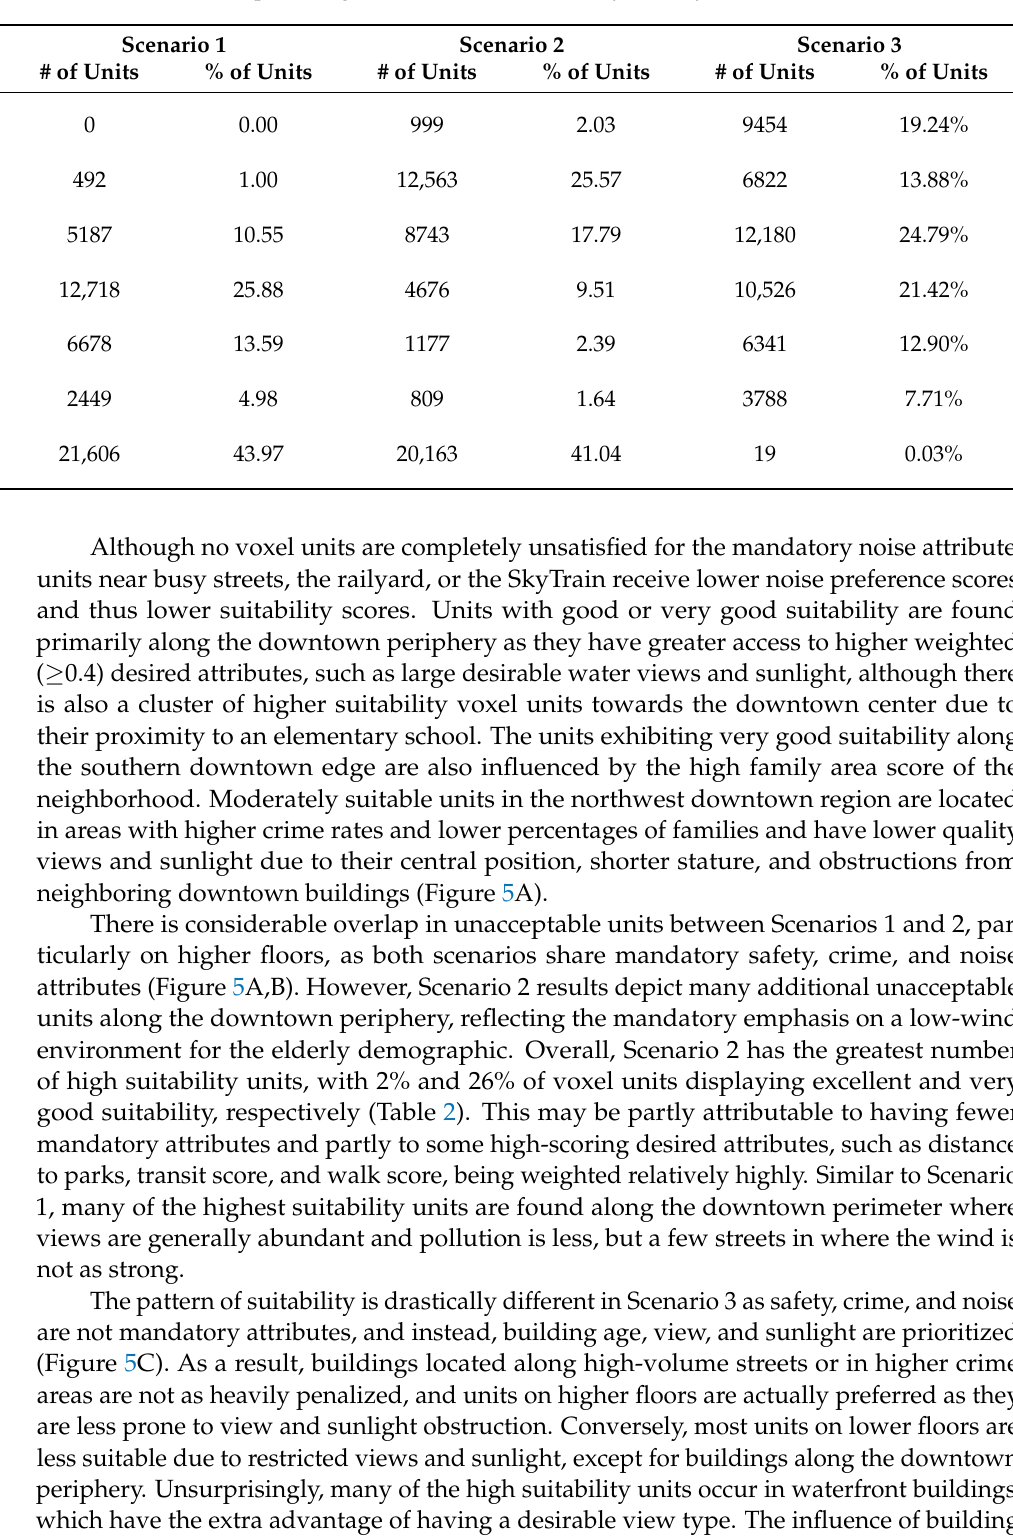
Table 2. Number and percentage of units in each suitability class by